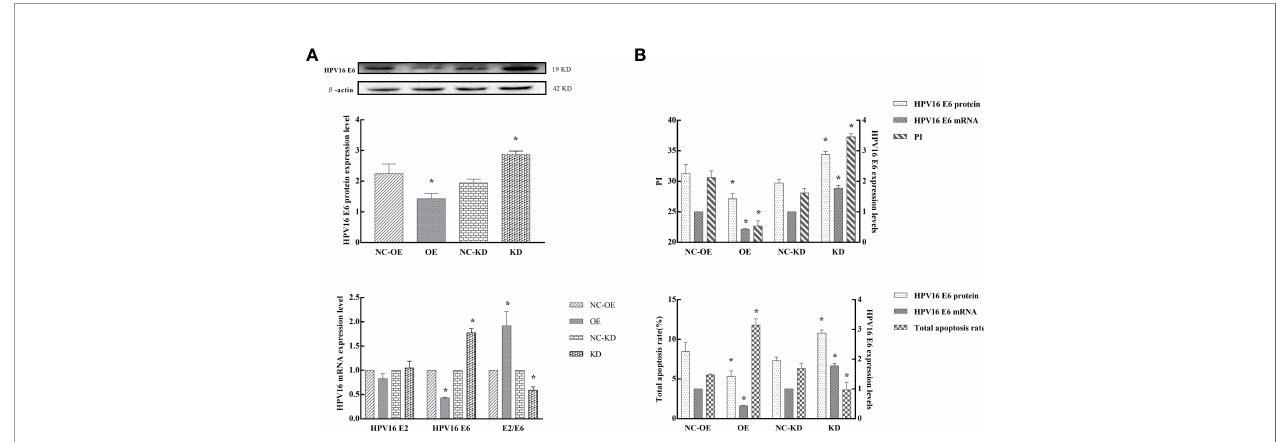
FIGURE 6 | hnRNP E1 effects on HPV16 oncogene and subsequent changes in cell biological function. Note: OE indicates hnRNP E1 overexpression group and NC-OE indicates the relative control group. KD indicates hnRNP E1 knockdown group and NC-KD indicates the relative control group. * P < 0.05. (A) The expression of HPV16 E2, and E6 were detected in SiHa cells by RT-qPCR and western blotting. (B) The relationship between HPV16 E6 expression, cell proliferation, and apoptosis in hnRNP E1-modi fi ed cells. The expression of HPV16 E2, and E6 were detected in SiHa cells by RT-qPCR and western blotting. The PI and total apoptosis rate were evaluated using fl ow cytometry analyses. As HPV16 E6 mRNA and protein expression levels decreased, the proliferation indices of SiHa cells decreased, while the total apoptosis rate increased. As HPV16 E6 expression increased, the proliferation indices of SiHa cells increased, while the total apoptosis rate